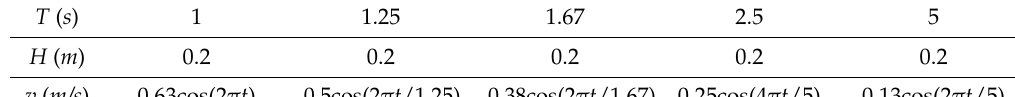
Table 2. Sinusoidal speeds at different periods.